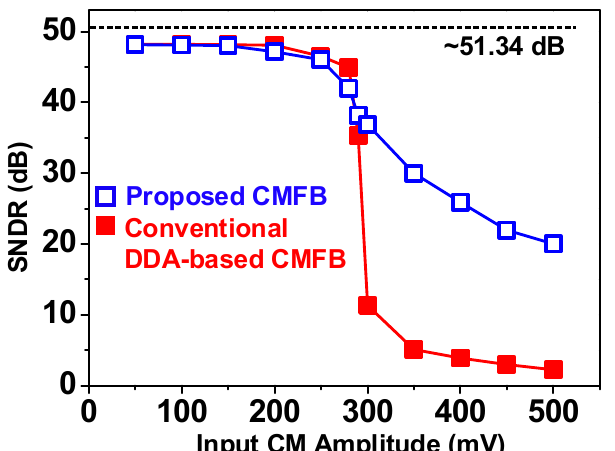
Figure 7. Signal-to-noise and distortion ratio (SNDR) variations according to input CM amplitude change.